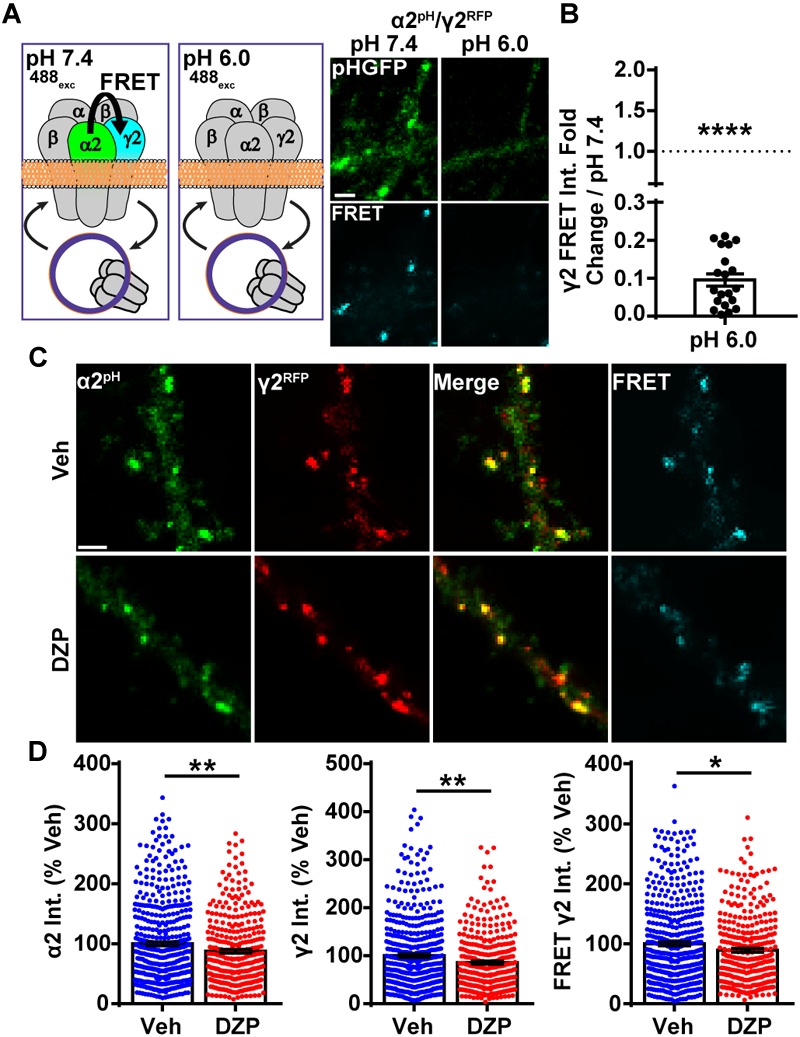
Intermolecular FRET reveals decreased dendritic synaptic α2/γ2 surface GABAARs after DZP. (A) Diagram and time-series images of cortical neurons expressing donor α2pH (green) and acceptor γ2RFP during imaging at pH 7.4 and pH 6.0. Surface α2pH (green) signal and intermolecular FRET (teal) between α2/γ2 subunits occurs at pH 7.4, but is eliminated by brief wash with pH 6.0 extracellular saline and quenching of the α2pH donor pHGFP fluorescence. (B) Quantification of relative FRET at pH 7.4 and pH 6.0 (n = 20 synapses). (C) Neurons α2pH (green) and γ2RFP (red) were treated with vehicle or DZP for 20–28 h ± and then subjected to live-imaging. For each cell, an initial image used 488 nm laser excitation to identify surface α2pH and FRET γ2RFP. A second image was taken immediately afterwards to acquire γ2RFP total levels (561 nm laser excitation). Dendritic lengths show multiple synaptic clusters with α2/γ2 surface GABAARs. (D) Synaptic cluster intensity quantification of α2pH, γ2RFP, and FRET γ2RFP (at least 15 synapses per cell; n = 335–483 synapses; 6 independent cultures). Int., fluorescence intensity. Image scale bars = 2 μm [∗p ≤ 0.05, ∗∗p < 0.01, ∗∗∗∗p < 0.0001, paired t-test (B), Student’s t-test (D); error bars ± s.e.m].